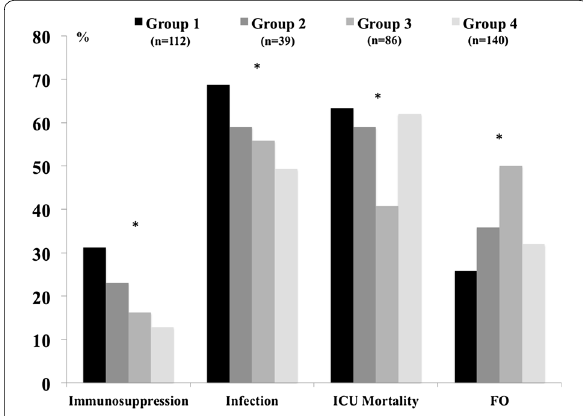
Fig. 2 Proportion of patients on immunosuppressive therapy, devel‑ oping infections, non‑survivors and with favourable neurological outcome (FO) according to the different groups of lymphocyte levels over the first 48 h after arrest: “group 1” included patients with persis‑ tent lymphopaenia throughout the 48 h; “group 2” included patients with lymphopaenia on admission but with normal lymphocyte counts at 48 h; “group 3” included those who had normal lymphocyte counts throughout the 48‑h study period; and “group 4” those with normal lymphocyte counts on admission but who had developed lymphopaenia by 48